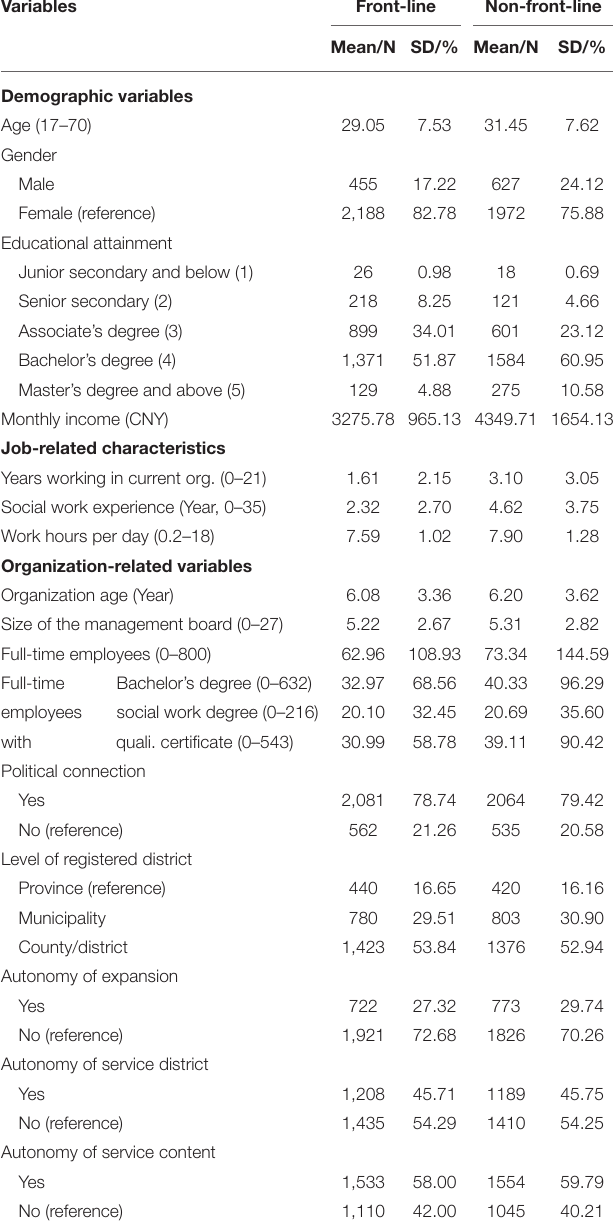
TABLE 1 | Descriptive statistics of controls for front-line and non-front-line